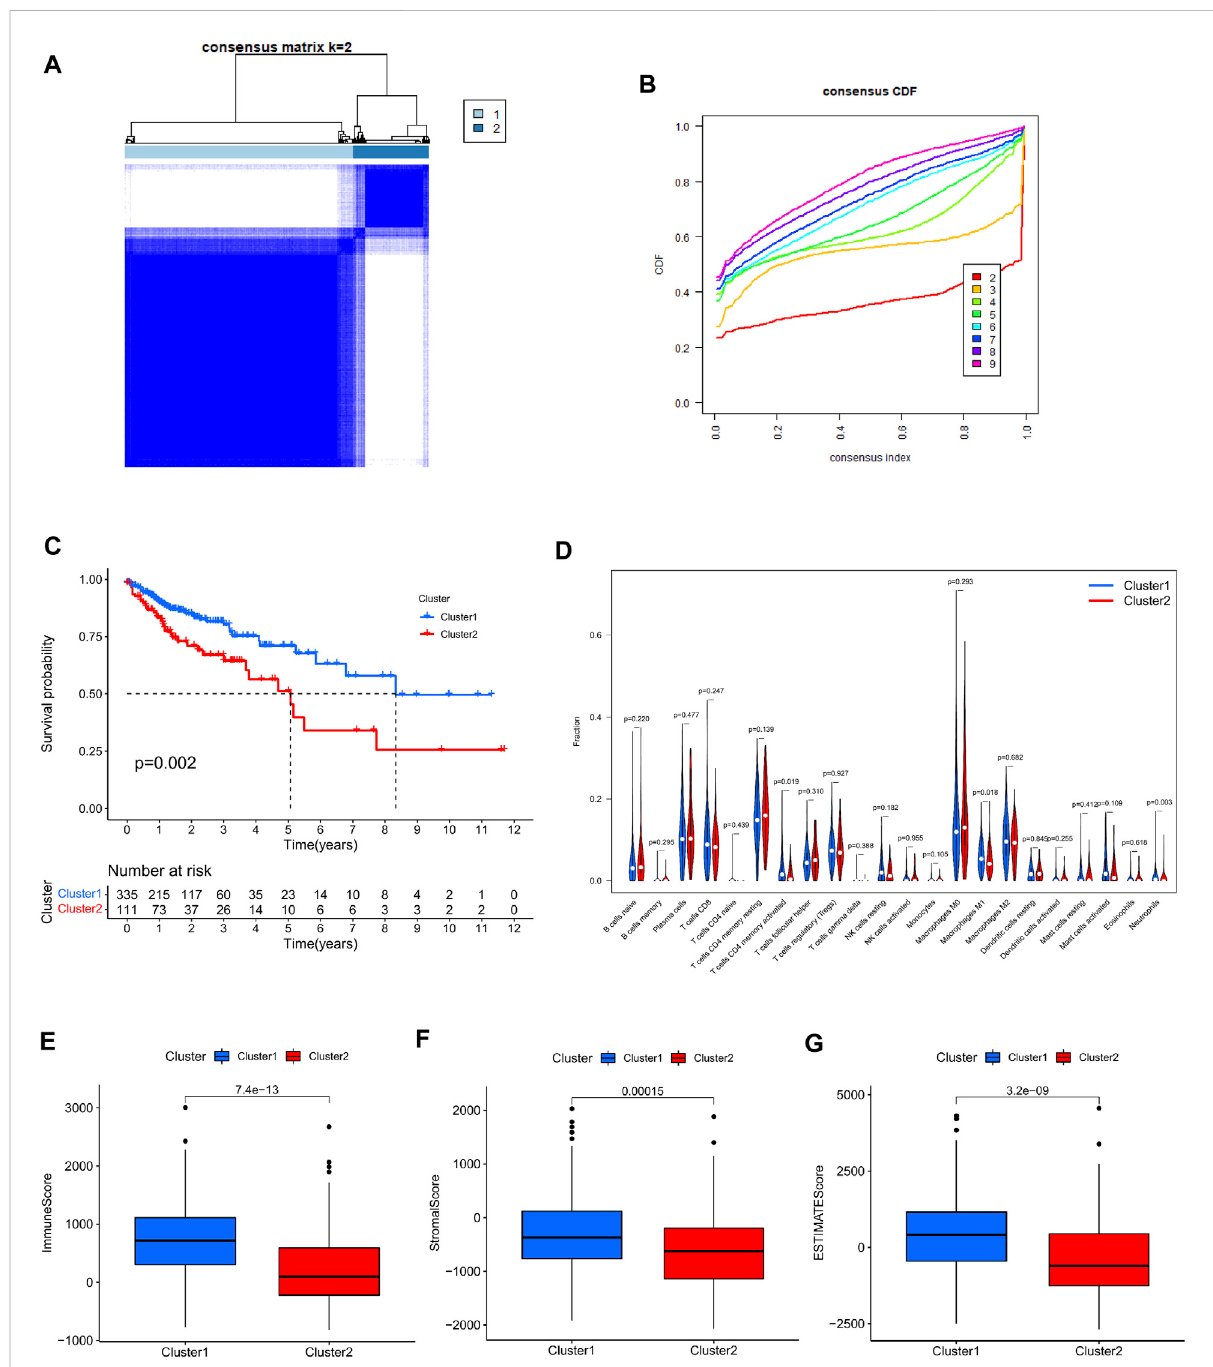
FIGURE 2 Consensus clustering analysis based on cuproptosis prognosis-associated lncRNAs. (A) 446 colon cancer patients were divided into two clusters ( k = 2) according to a consistent clustering matrix. (B) Relative change in area under the CDF curve for k = 2 – 9. (C) Kaplan-Meier curve of overall survival in colon cancer patients with two clusters. (D) In fi ltration of 22 immune-in fi ltrating cells in clusters 1 and 2 Abundance. (E – G) Comparison of immune scores, stromal scores, and assessment scores for cluster 1 and cluster